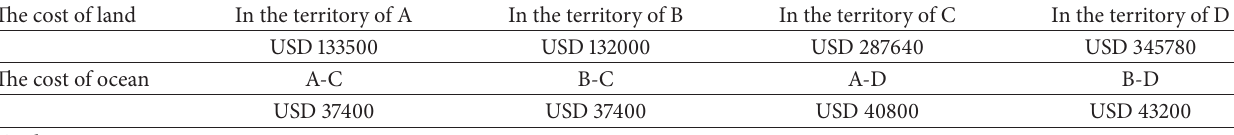
Table 14: Simulation results of freight cost in Scheme 4.